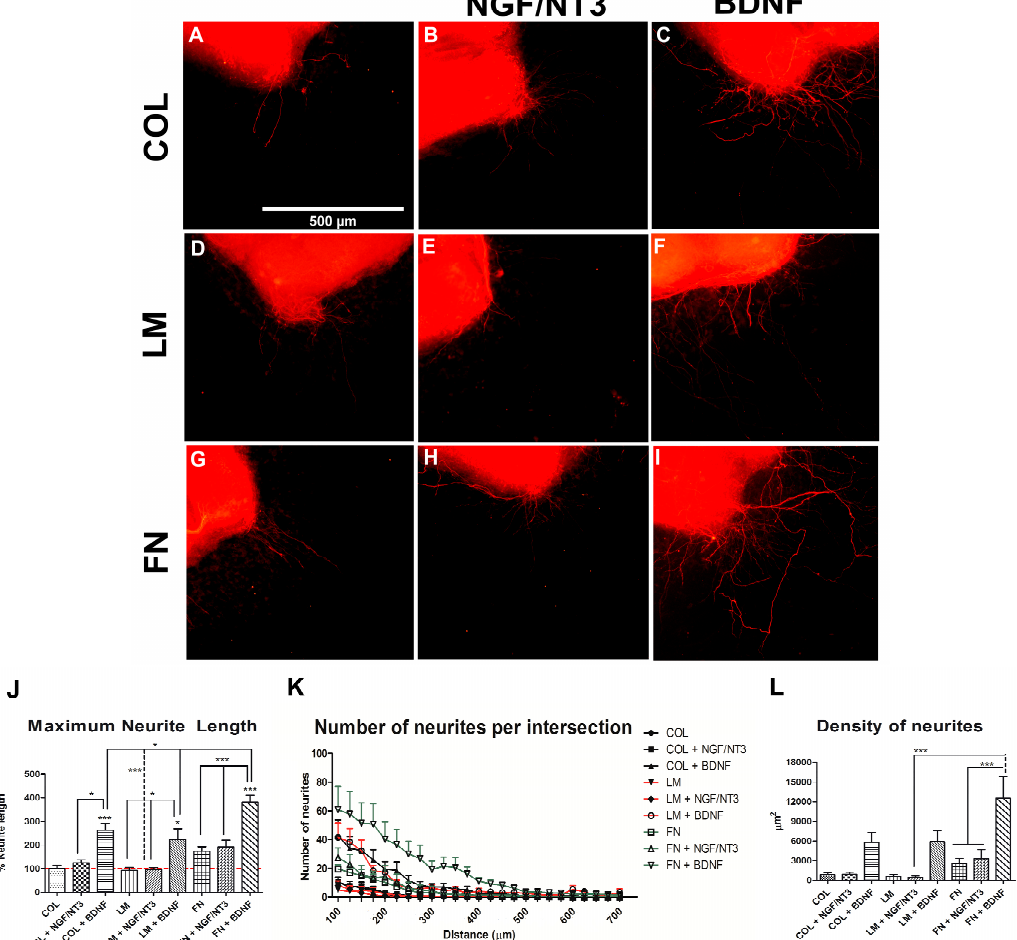
Figure 1. ( A – I ) RT97 stained neurites from spinal cord slices cultured within a 3D collagen matrix alone, and with addition of NGF/NT3 or brain-derived neurotrophic factor (BDNF) ( A – C ); with 20% laminin, plus NGF/NT3 or BDNF ( D – F ); and with 20% fibronectin, plus NGF/NT3 or BDNF ( G – I ); plots representing maximum neurite length in the different DRG culture conditions ( J ); quantification of the number of neurites grown at increasing distance from the DRG body, dashed line represents the values for COL control group (100%) ( K ); and plots of the quantified area under each curve of K graph ( L ). Data expressed as mean ± SEM. * p < 0.05 and *** p < 0.001.